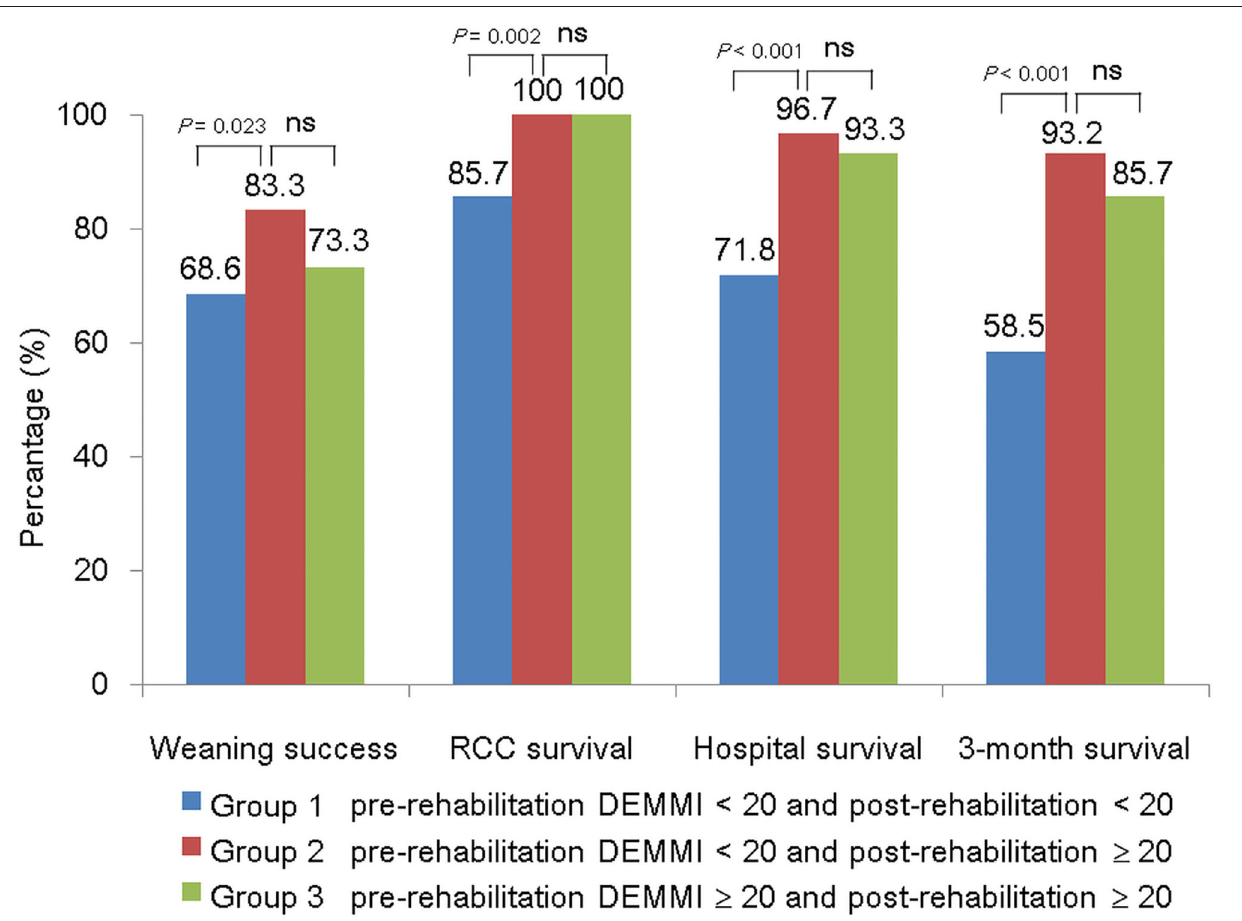
FIGURE 3 | Comparison of weaning and survival status among patient groups stratified by different pre- and post-rehabilitation DEMMI combination. DEMMI, the de Morton Mobility Index; ns, not significant; RCC, respiratory care